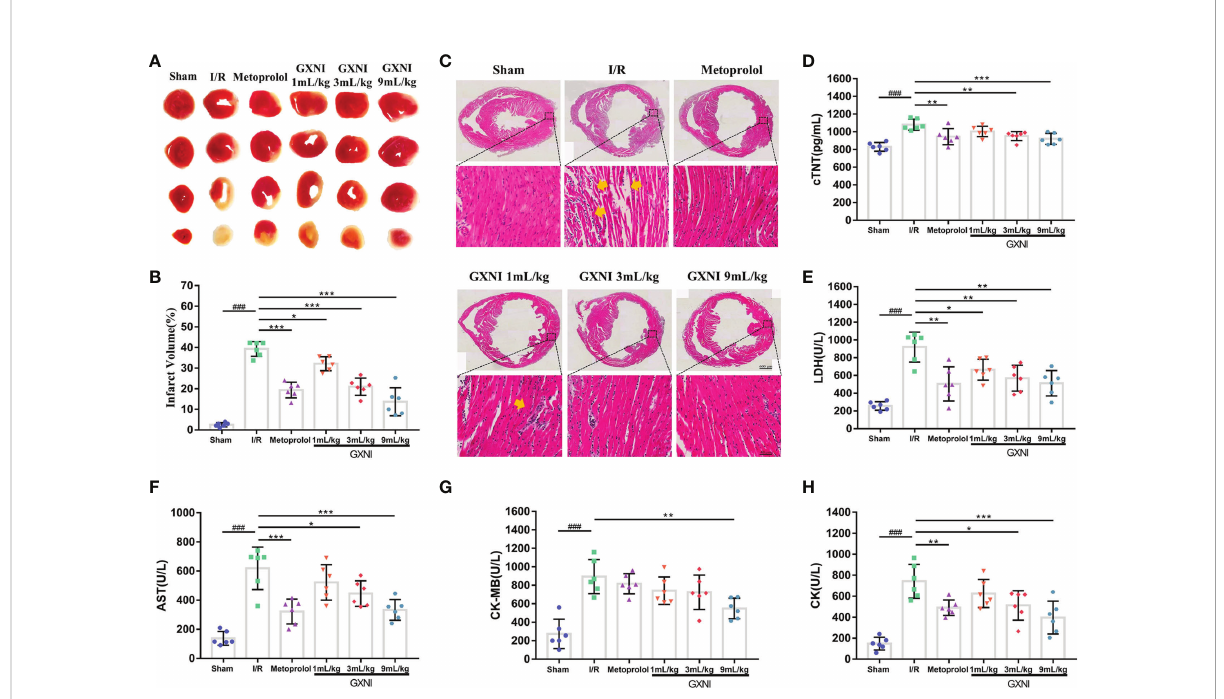
FIGURE 2 GXNI reduced the volume of myocardial infarction in I/R mice. After 30 min of myocardial ischemia and 24 hrs of reperfusion, the myocardial tissue of mice in each group, including sham, I/R, metoprolol, GXNI 1 mL/kg, GXNI 3 mL/kg and GXNI 9 mL/kg, were stained with TTC. (A) Representative images of TTC staining for each group. Normal myocardial tissue was in red, while the infarcted area was in white. (B) Quanti fi cation of infarct volume in each group. (C) Representative pictures of H&E staining results of myocardial tissue, in which myocardial injury was indicated by yellow arrow. The upper part was the panoramic scanning image of the cross-section of the cardiac tissue in each group (Scale bar = 600 m m), and the lower part was the corresponding local image (Scale bar = 40 m m). (D – H) The levels of LDH, AST, CK, CK-MB and cTNT in serum of mice in different groups were measured by automatic biochemical analyzer and ELISA kit. Values were expressed as mean ± SEM (n = 6). ### P < 0.001 vs. sham group, * P < 0.05, ** P < 0.01, *** P < 0.001 vs. I/R